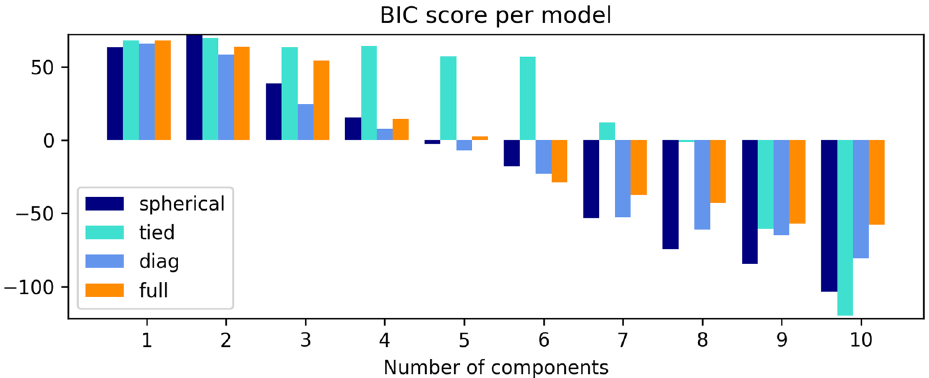
Figure 2. 5 BIC score for various numbers of Gaussian components in GMM in analysis for fatty acid